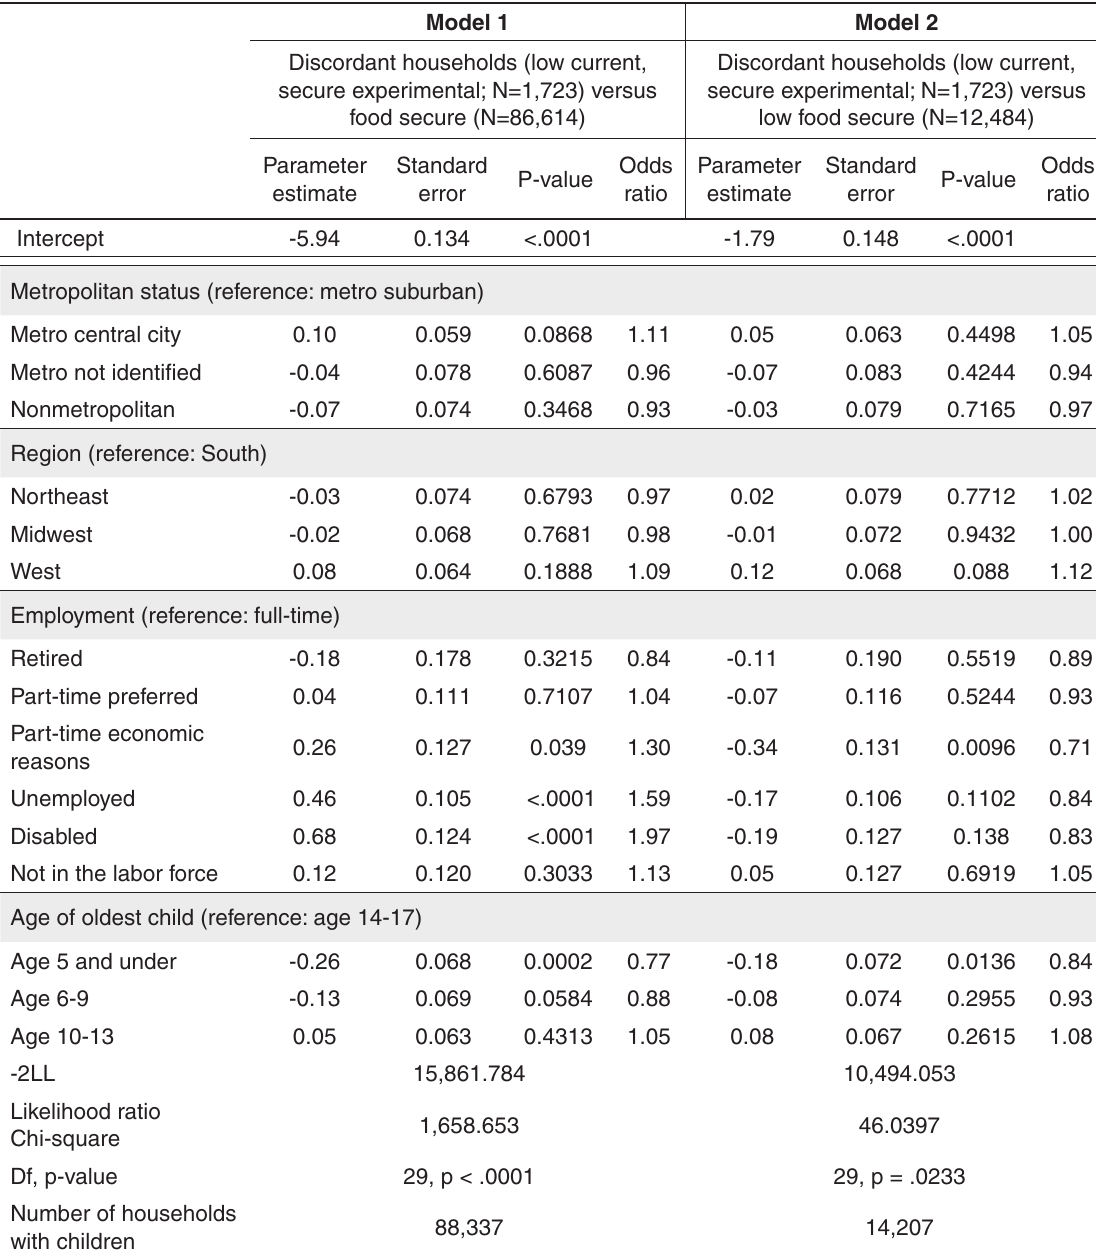
Logistic regression model comparing discordant households (low food secure current, food secure experimental) with households consistent on both classification methods,